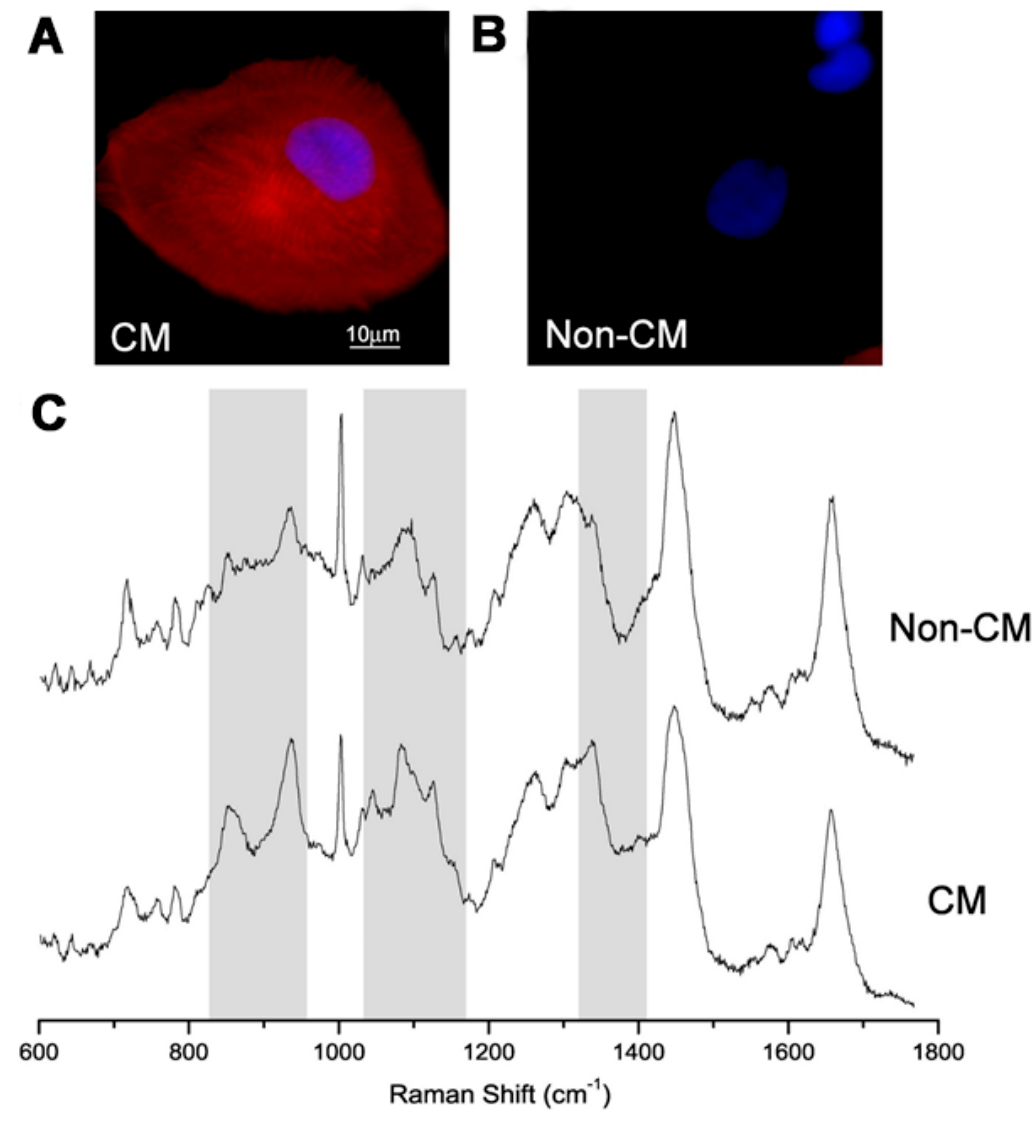
Figure 6. Typical immunostaining images of: ( A ) individual cardiomyocytes (CM); and ( B ) non- cardiomyocytes (non-CM) derived fromhuman embryonic stem cells (hESCs). Cell nuclei DAPI ( blue ); cardiac a-actinin ( red ). ( C ) Raman spectra of the same cells. Reprinted with permission from [67]. Copyright 2018, Elsevier.